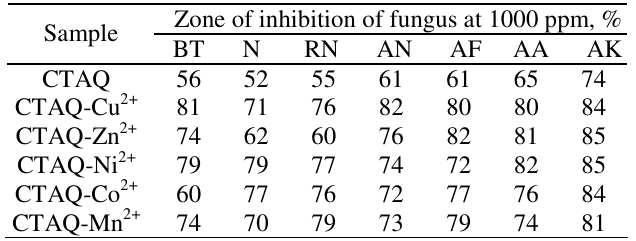
Table 3. Antifungal activity of CTAQ ligand and its metal